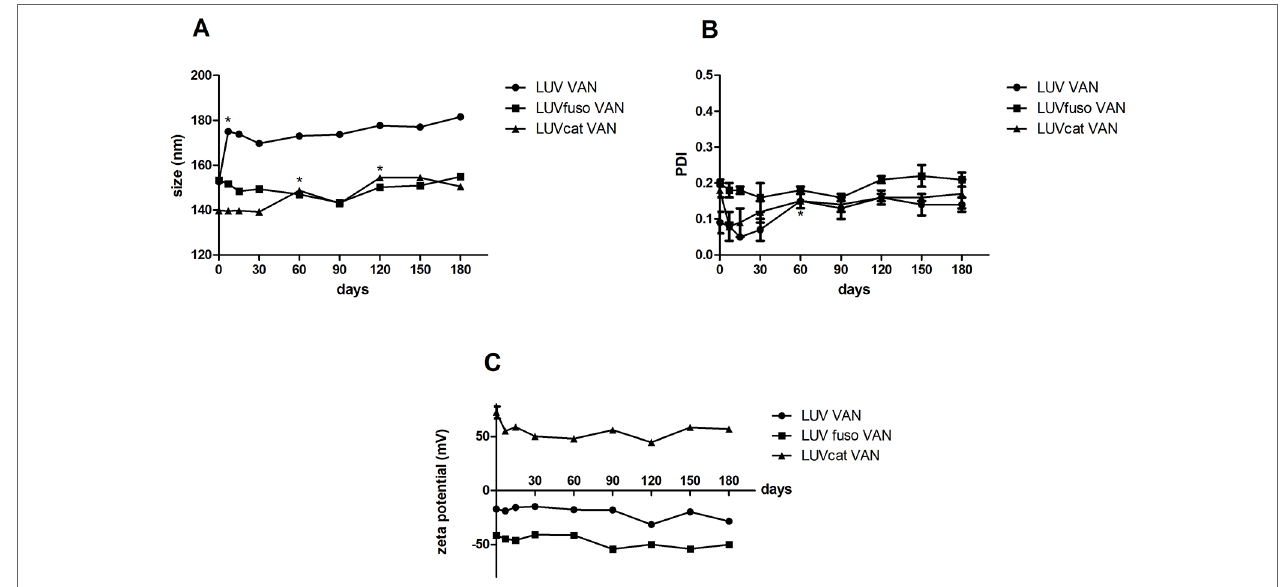
FIgUre 2 | Size (A) , PDI (B) and Zeta potential (C) for VAN liposomal formulations analyses during 180 days. The asterisk “*” indicates statistically significant difference between the drug treatment and its respective untreated control at p < 0.05 (One-way ANOVA, followed by Tukey’s post-hoc test).